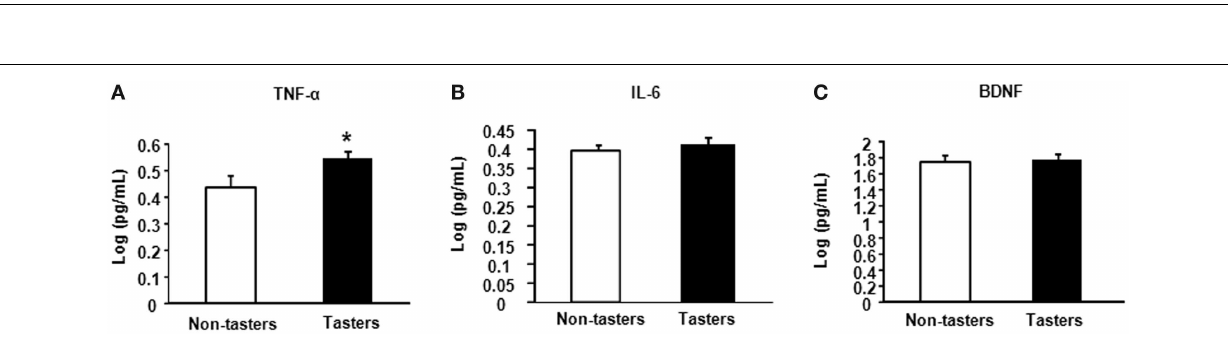
FIGURE 2 | Plasma appetite hormones . Appetite hormones including leptin (A) , amylin (total) (B) , GIP (C) , PP (D) , and PYY (E) were measured. Results were log-transformed and subjected to a non-paired two-tailed t -test. A value of p < 0.05 was considered statistically significant.